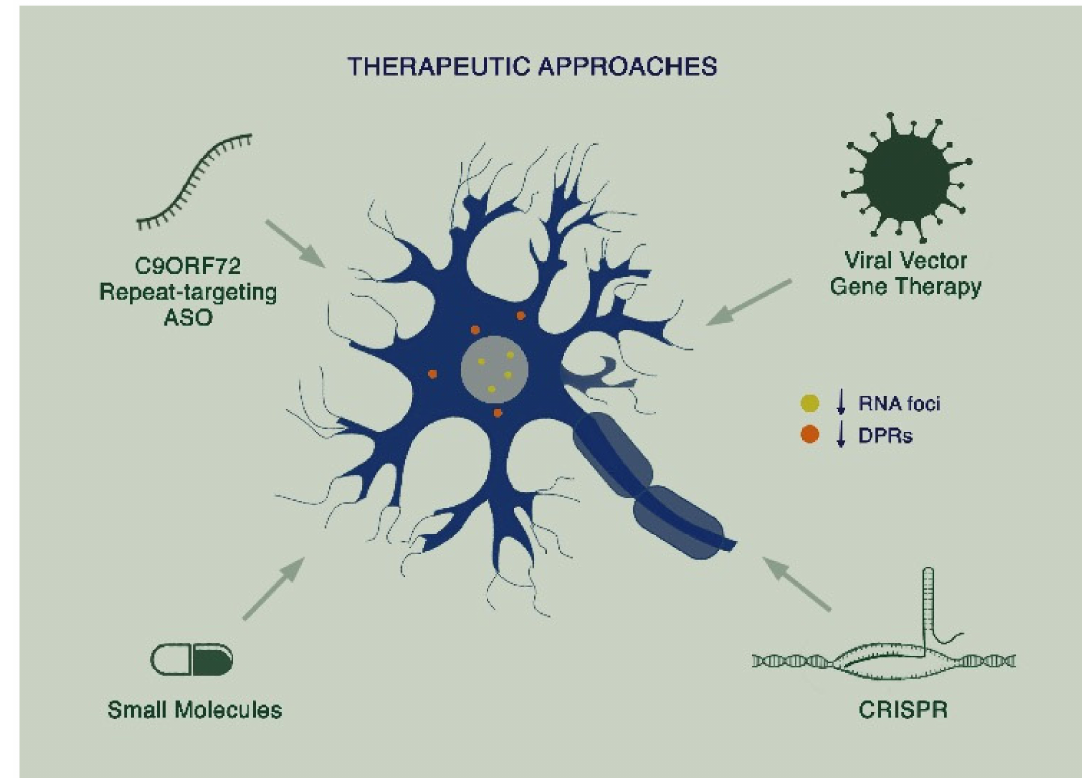
Figure 2. Proposed therapeutic approaches in C9ALS-FTD: Targeting of toxicity arising from sense and antisense RNA foci and dipeptide repeat proteins (DPRs) through a combination of therapies including repeat-targeting antisense oligonu- cleotides (ASOs), viral vector gene therapy, small molecules, and